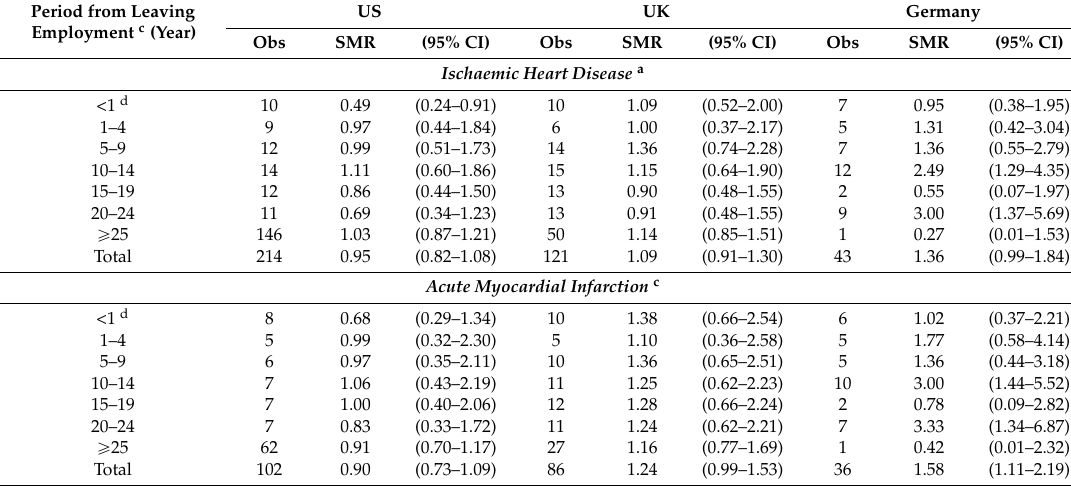
Table 7. Standardised mortality ratios (SMRs) for cardiac a,b mortality based on national rates by period from leaving employment, in carbon black production workers (inception cohorts, US: follow-up ě 1979).